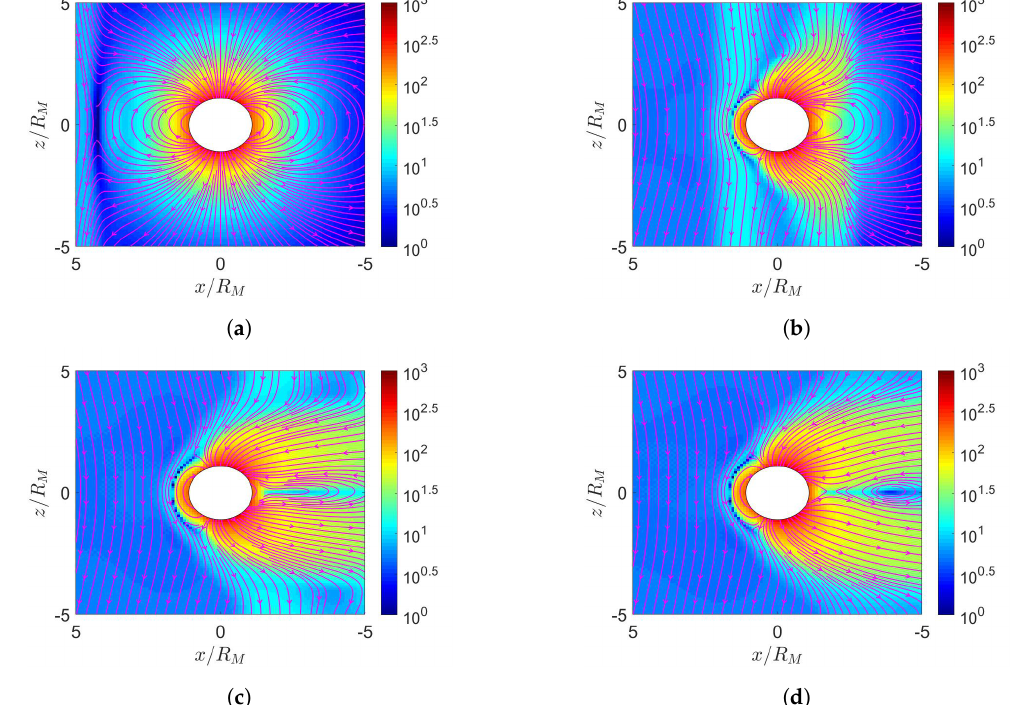
Figure 9. Time evolution of Mercury’s magnetic field distribution under southward IMF. ( a ) t = 12.8 s, ( b ) t = 51.5 s, ( c ) t = 90 s, ( d ) t = 128.8